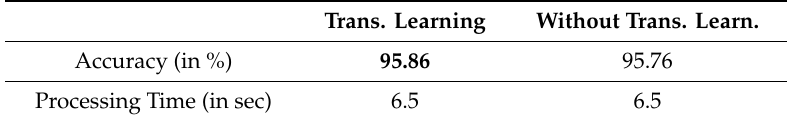
Table 7. Accuracies and processing time (in sec) obtained with and without applying transfer learning on the Car dataset.